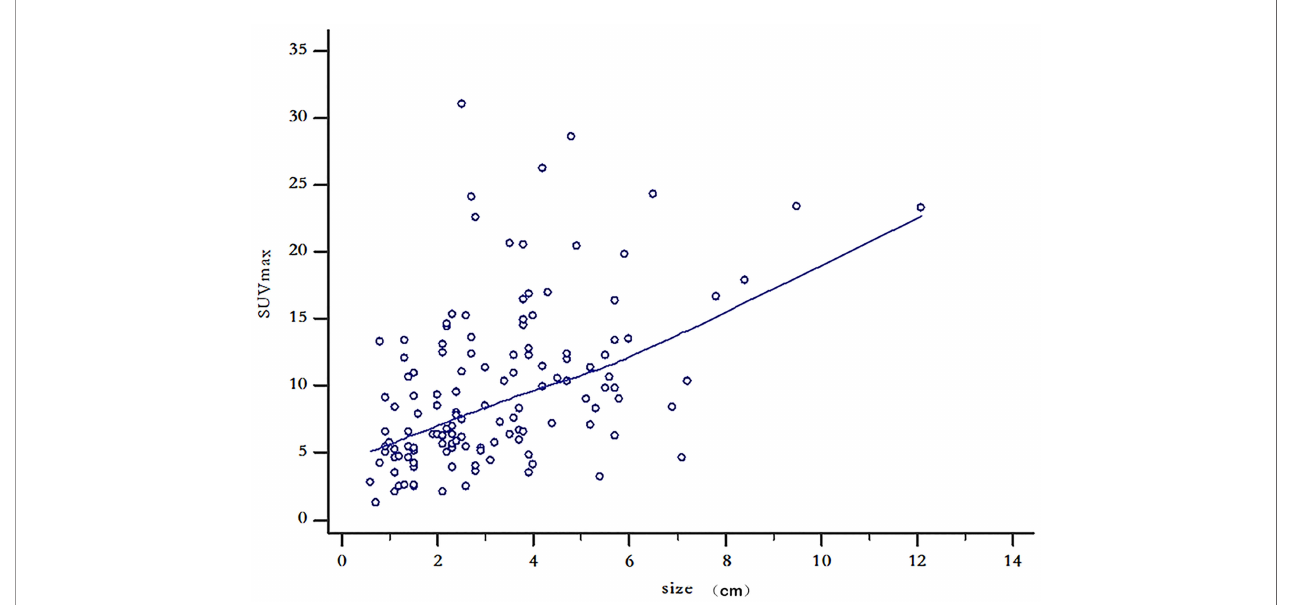
FIGURE 2 | Scatter diagram of maximum lesion size and standardized uptake maximum value in 132 patients with colorectal peritoneal